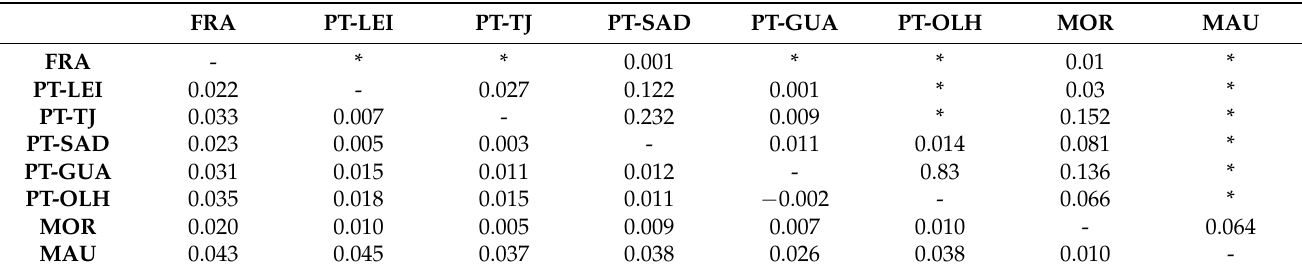
Table 3. Pairwise estimates of F ST values among Argyrosomus regius Atlantic location sites (below diagonal) and corresponding p -values (above diagonal; * p < 0.0008 (Bonferroni correction)). For location sites’ acronyms, please check Table 1.